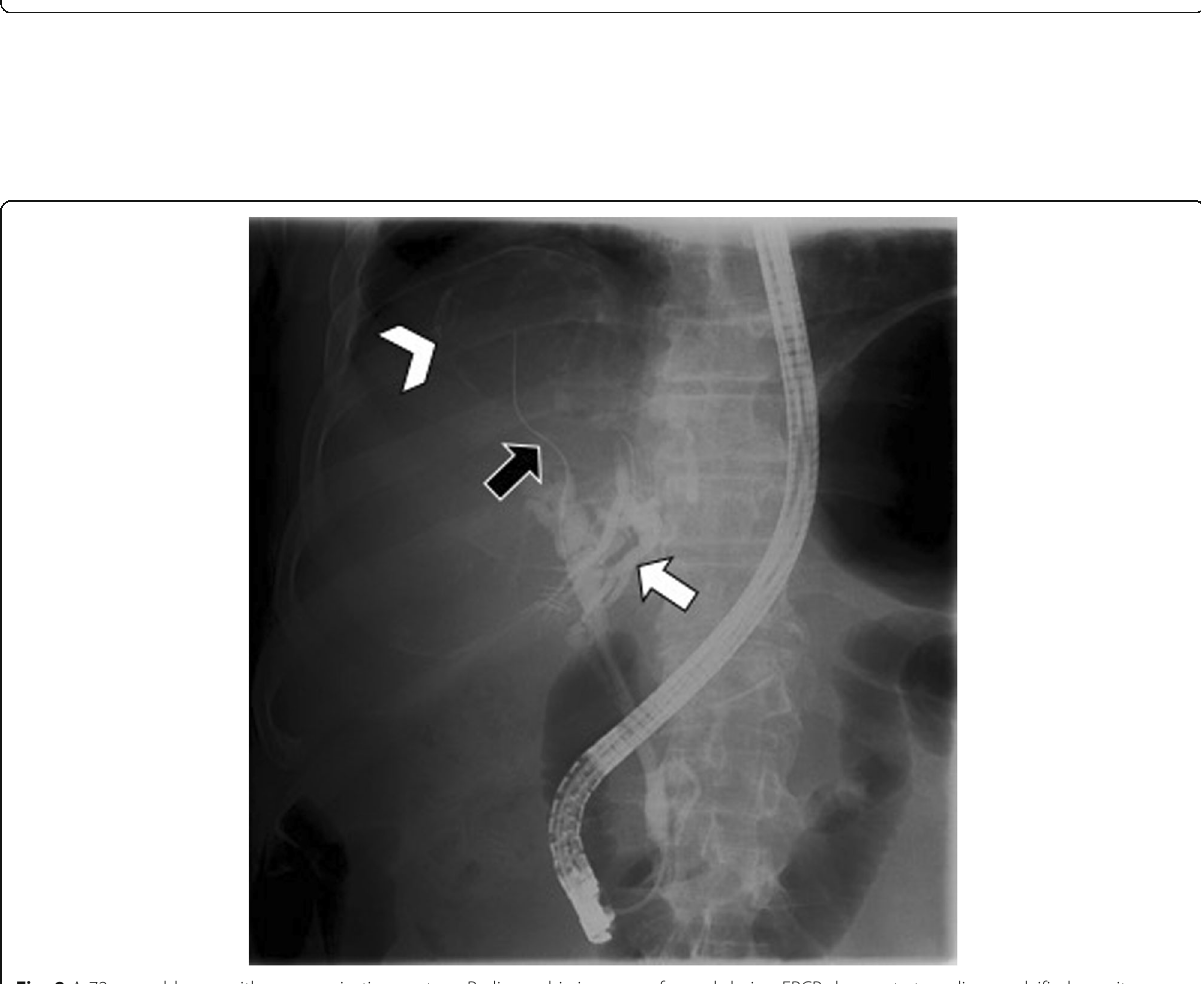
Fig. 8 A 72-year-old man with communicating rupture. Radiographic image performed during ERCP demonstrates a linear calcified opacity (arrowhead) — representing a hepatic hydatid cyst — and intrahepatic bile duct dilatation (white arrow). The catheter (black arrow) introduced in biliary tree enters directly into the cyst, documenting the cysto-biliary